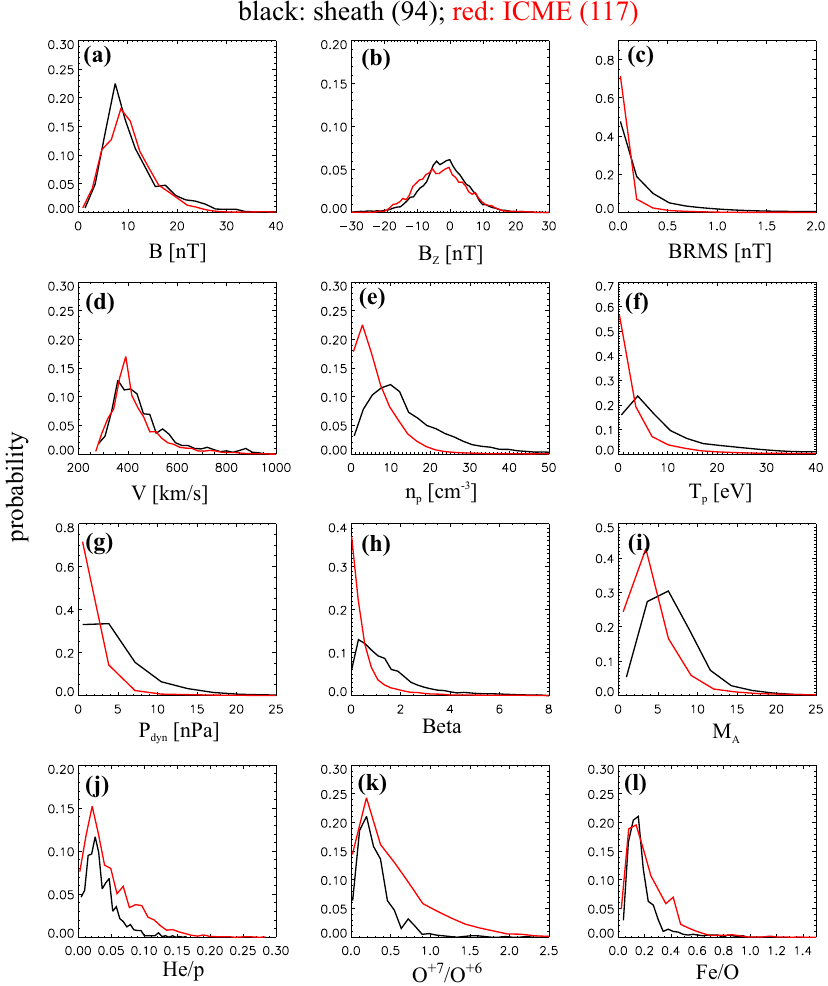
Fig. 18 Probability distributions of various solar wind parameters in ICME sheaths (black) and ICME (red). The panels give: a magnetic field magnitude, b IMF north-south component, c root-mean-square of the magnetic field, solar wind d speed, e density, f temperature, g dynamic pressure, h plasma beta, i Alfvén Mach number, and j alpha to proton (He ++ /p), k O + 7 / + 6 , and l Fe/O ratios. Panels a – i The data sets are 5-min OMNI data, panel j 1-h OMNI data and panels k – l are 1-h (2-h after August 2011) ACE/SWICS data. The numbers in parenthesis show the number of sheaths and